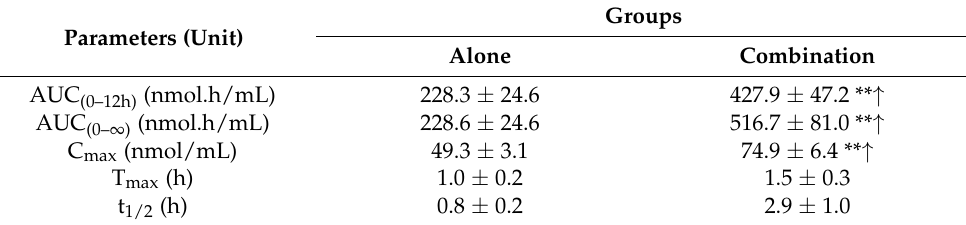
Table 3. Comparison of pharmacokinetic parameters of alcohol administered alone and combined with resveratrol.